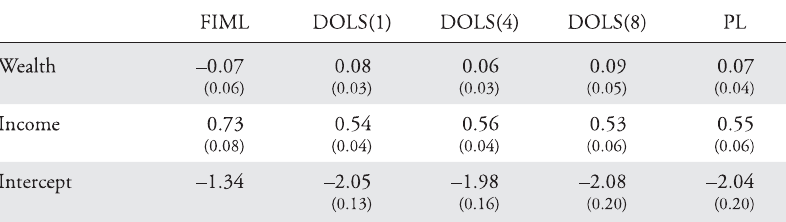
Table 1: Estimation of the Cointegrating Vector: Different